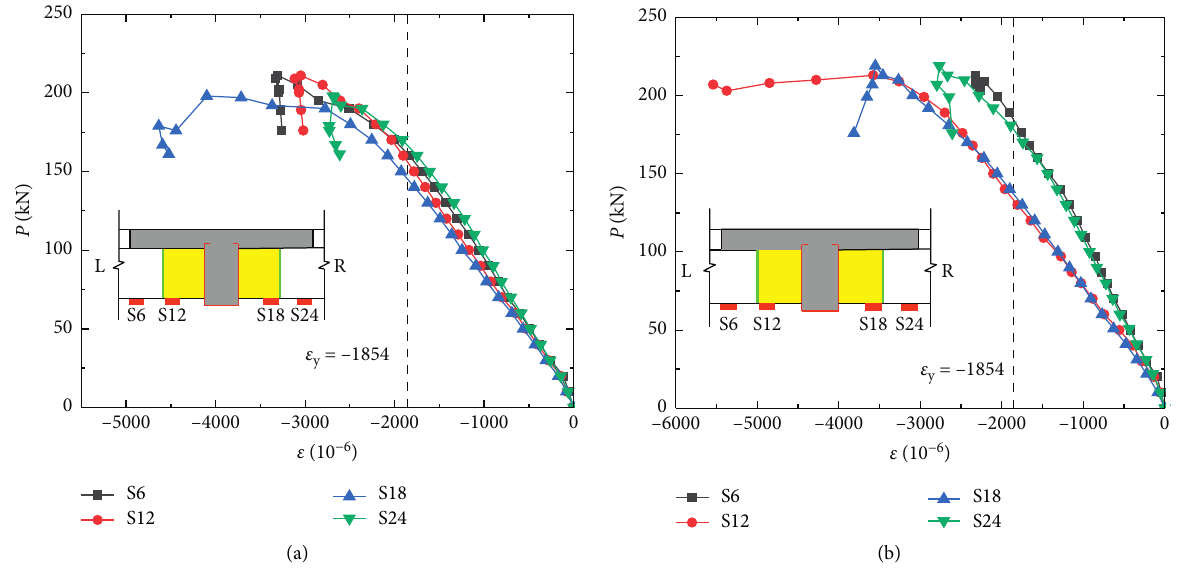
Figure 14: Load-compressive strain curves. (a) BGJ1 and (b)